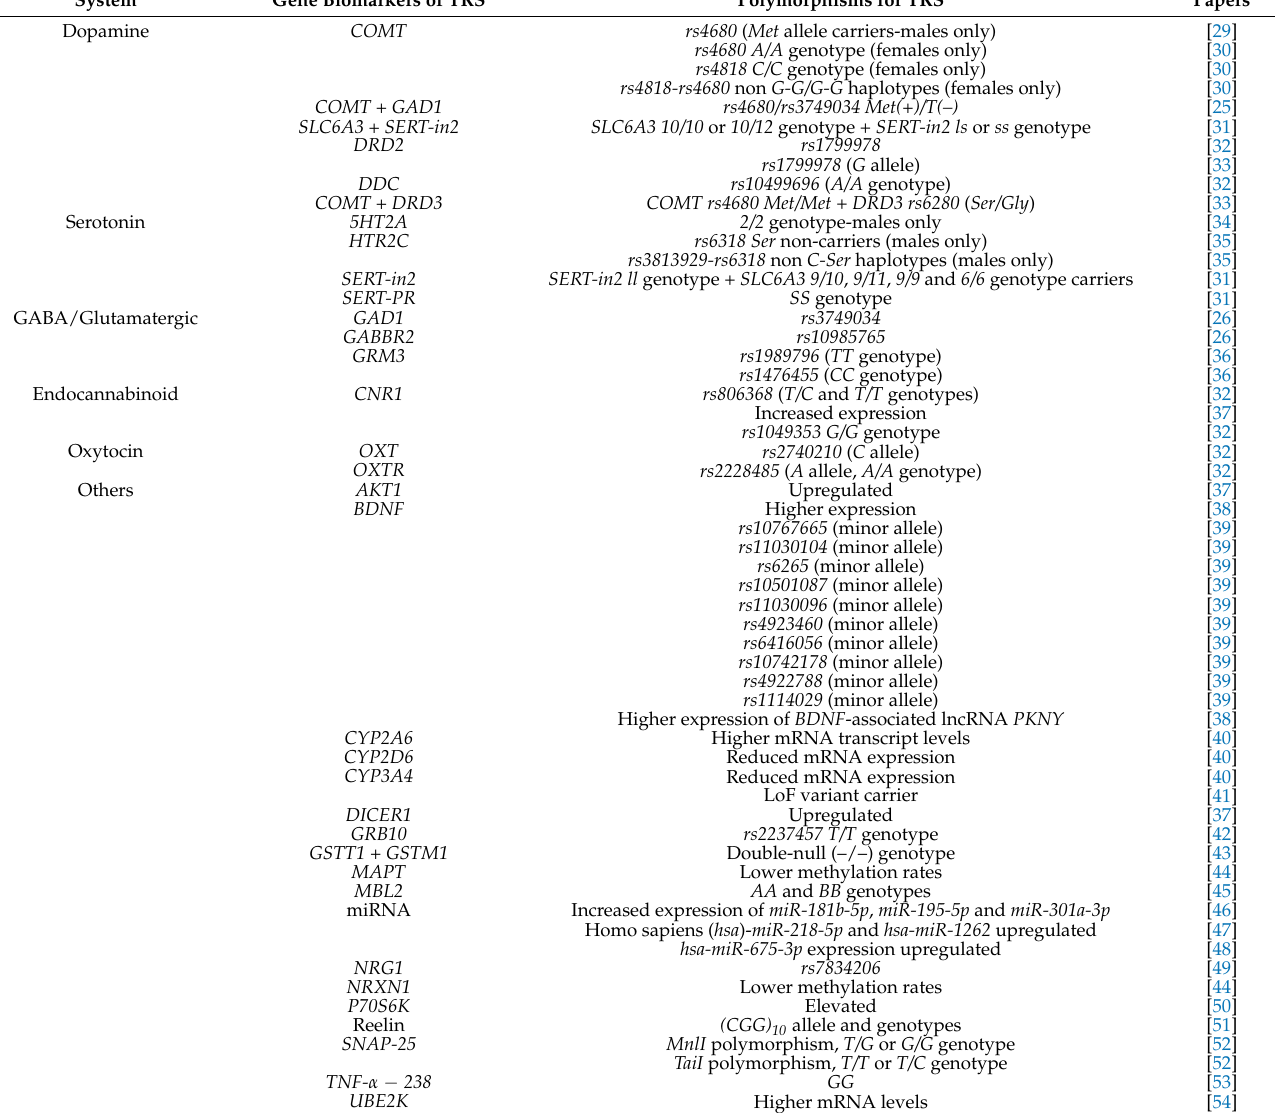
Table 1. Risk genes/polymorphisms for treatment-resistant